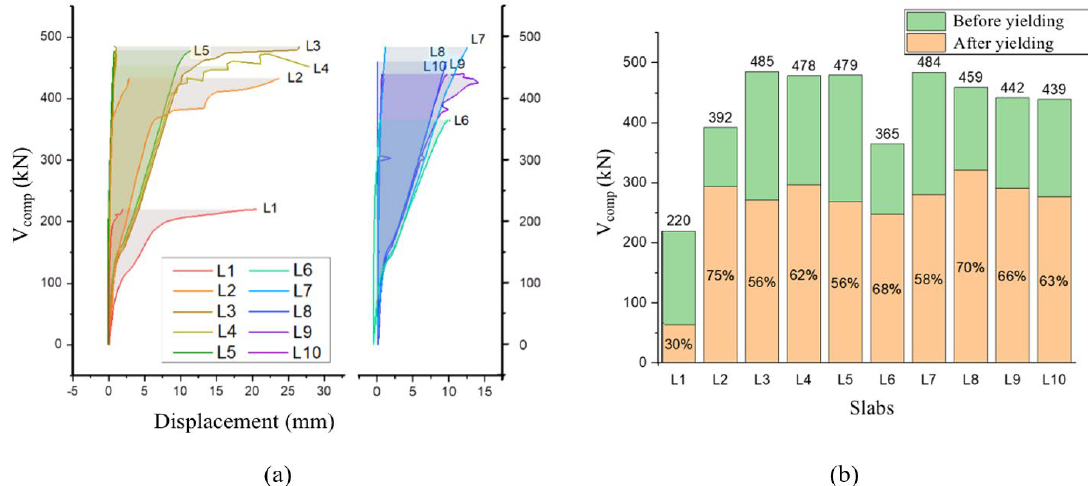
Figure 12. (a) Load x displacement curves and (b) Ductile behavior of the